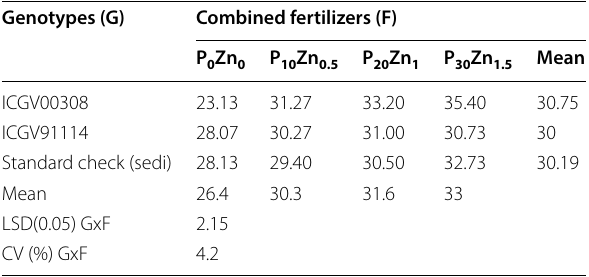
Table 3 The interaction effect of genotypes and PZn fertilizer on pod